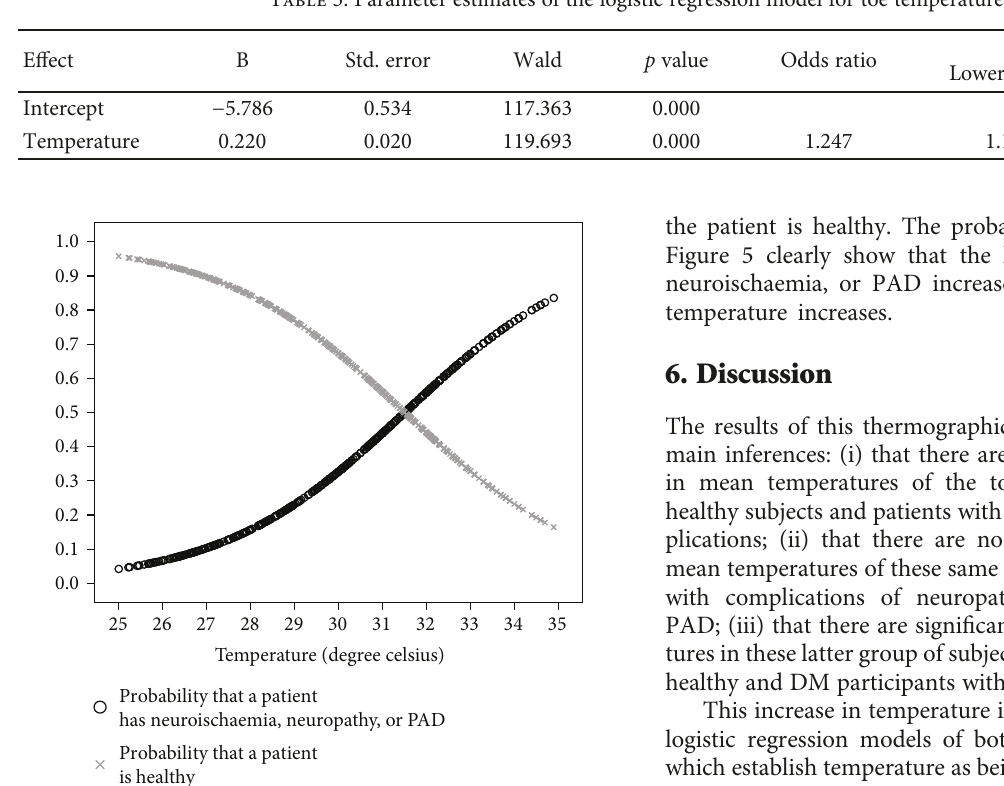
Table 3: Parameter estimates of the logistic regression model for toe temperatures.